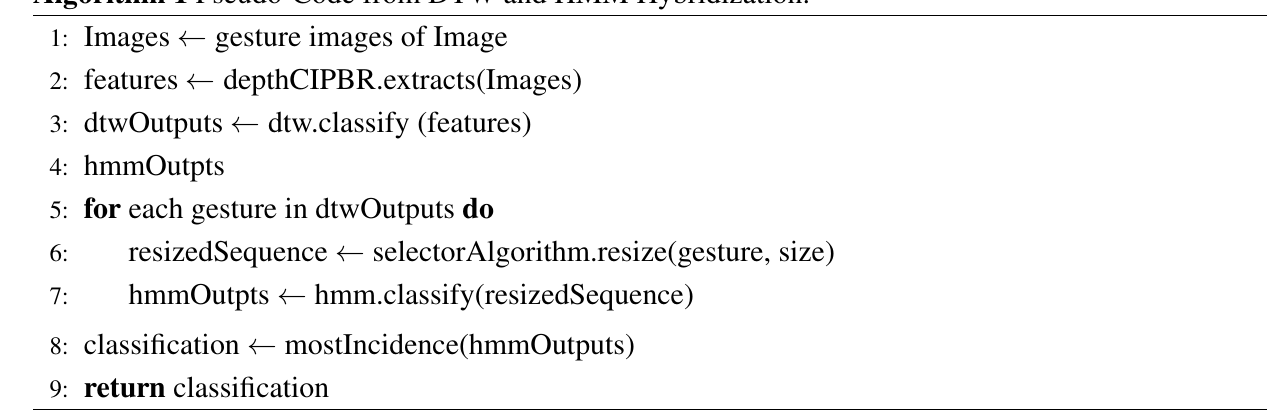
Algorithm 1 Pseudo-Code from DTW and HMM